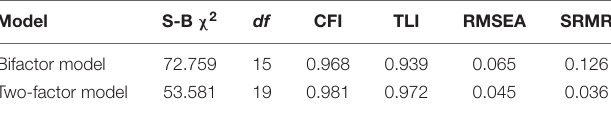
TABLE 2 | Confirmatory factor analysis for two competing measurement models.